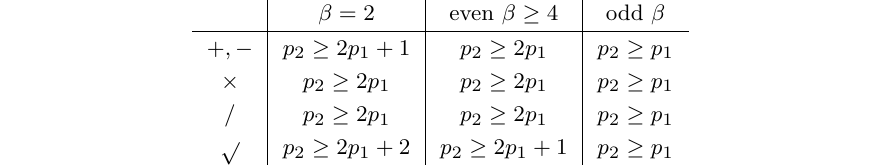
Table I. Hypotheses under which double rounding is innocuous for the FLX format ( β is the radix and p 1 and p 2 are the two precisions involved (c.f., Section 1 for formal definitions)). Division for odd radices is only valid with tie-break away.